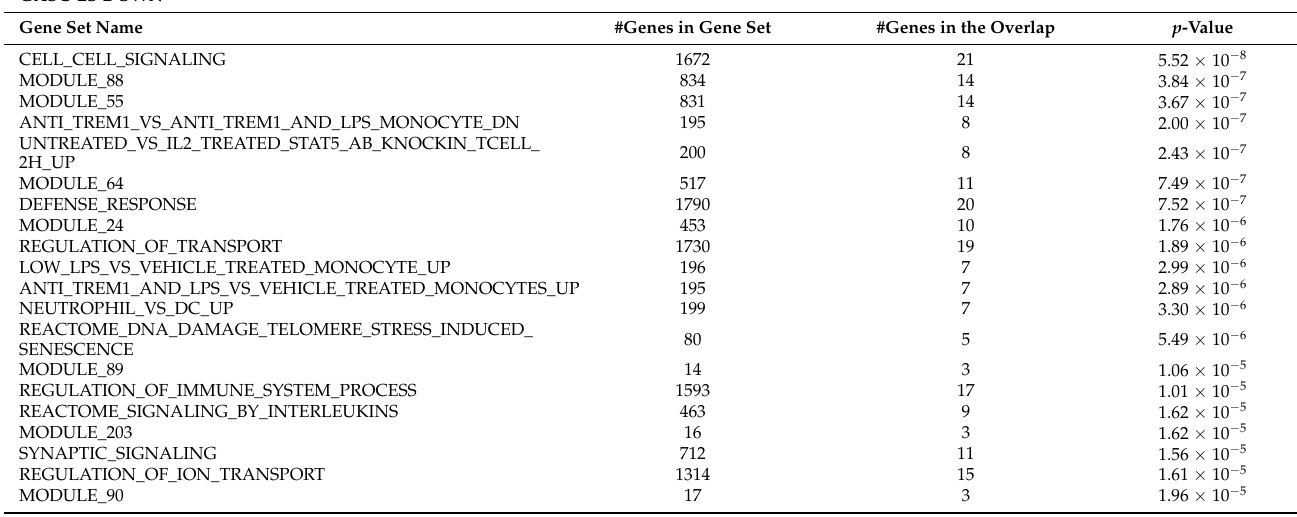
Table 2. The Top 20 significantly enriched MSigDB pathways associated with the specific lists of genes down-regulated in GASC-LS. The table reports the overall number (#) of genes involved in the annotated pathways, the number (#)of genes provided as input, and the associated p